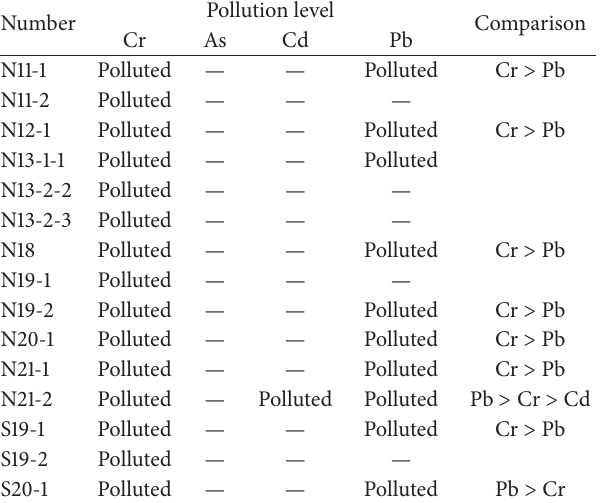
Table 6: Heavy metal pollution levels.